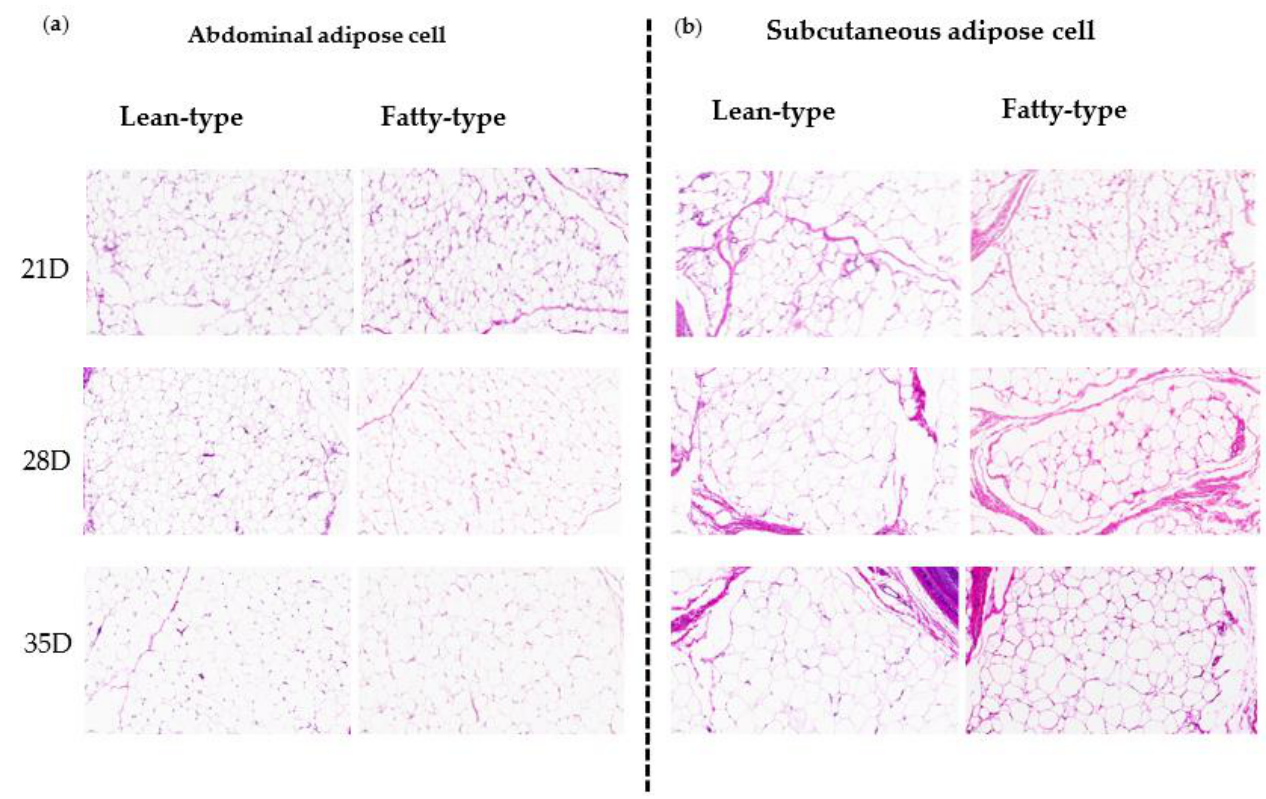
Figure 4. Representative H&E staining pictures of the abdominal adipose cell ( a ) and subcutaneous adipose cell ( b ) of 21 D, 28 D, and 35 D old ducks. The scale bar is 50 μm. Abbreviations: H&E, hematoxylin, and eosin.